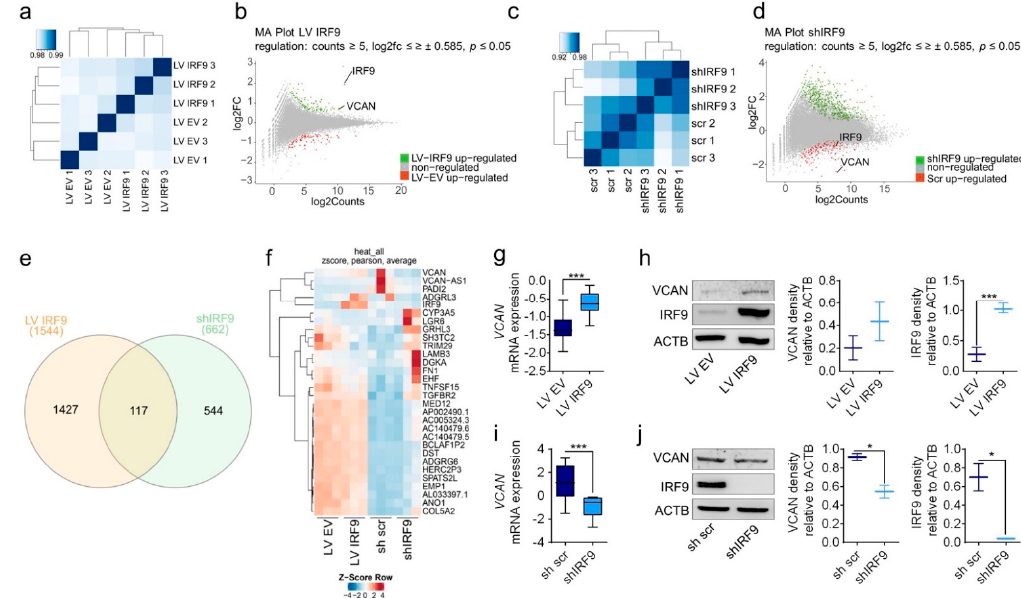
Figure 4. Following manipulation of IRF9, VCAN and IRF9 expression were correlated in LUAD cells. RNA-seq of transduced A549 cells was performed: A549 LV IRF9 cells were compared with A549 LV EV and A549 shIRF9 with A549 sh scr cells, respectively. ( a , c ), For correlations of RNA samples, only significantly regulated genes ( p < 0.05) were selected for further analysis. ( b , d ) MA plots of upregulated and downregulated genes from each set ( p < 0.05), with IRF9 and VCAN highlighted. ( e ) Venn diagram of A549 LV IRF9 cells and shIRF9 regulated genes. ( f ) Heatmap of the top 30 genes significantly regulated in both gene sets in opposite directions. VCAN was selected as a potential target of IRF9, and its expression was evaluated at ( g , i ) the mRNA and ( h , j ) protein expression levels, with quantification in IRF9-overexpressing and -silenced cells ( n = 6). Data are expressed as means ± standard error of the mean. Analysis was performed using one-way analysis of variance with Welch’s t -test: * p < 0.05; *** p <